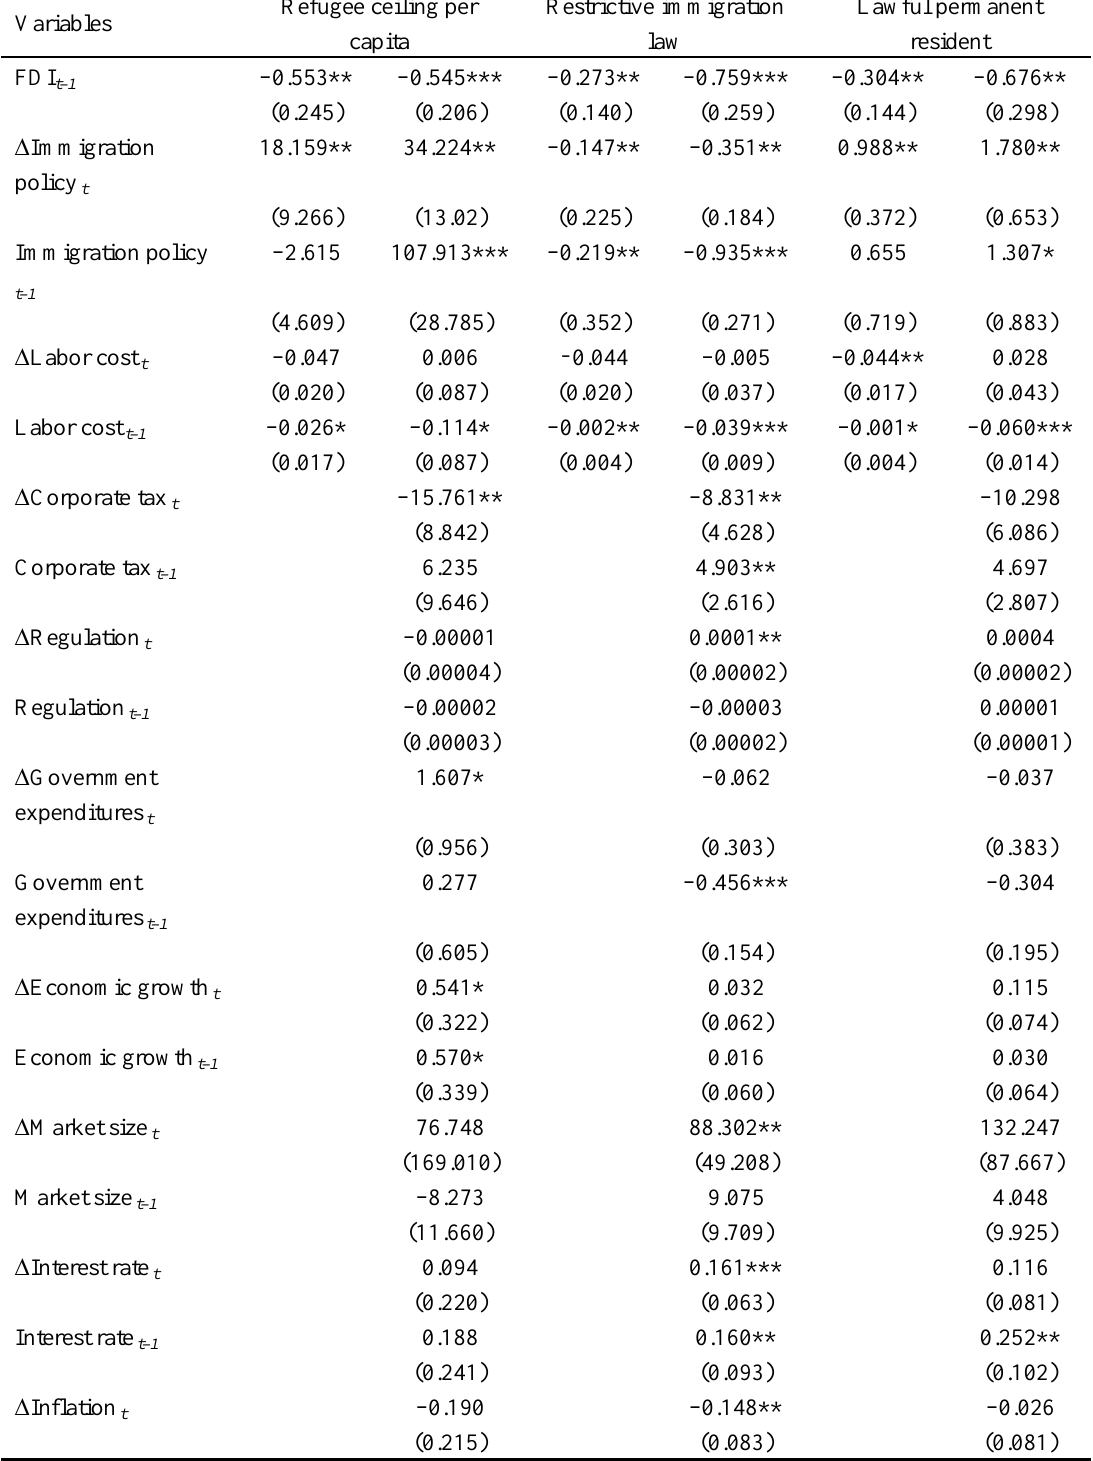
Table 4. The Impact of Immigration Policy on FDI Inflows in the